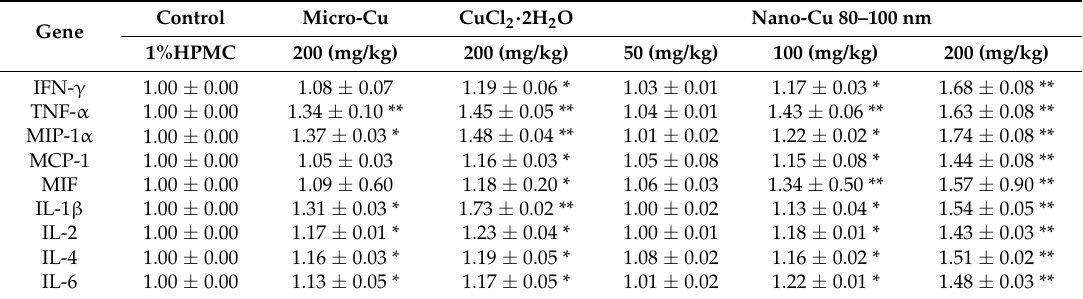
Table 4. Expression levels of genes associated with inflammation in rats treated with copper sources by oral administration over 28 consecutive days (2 − ∆∆ CT ).